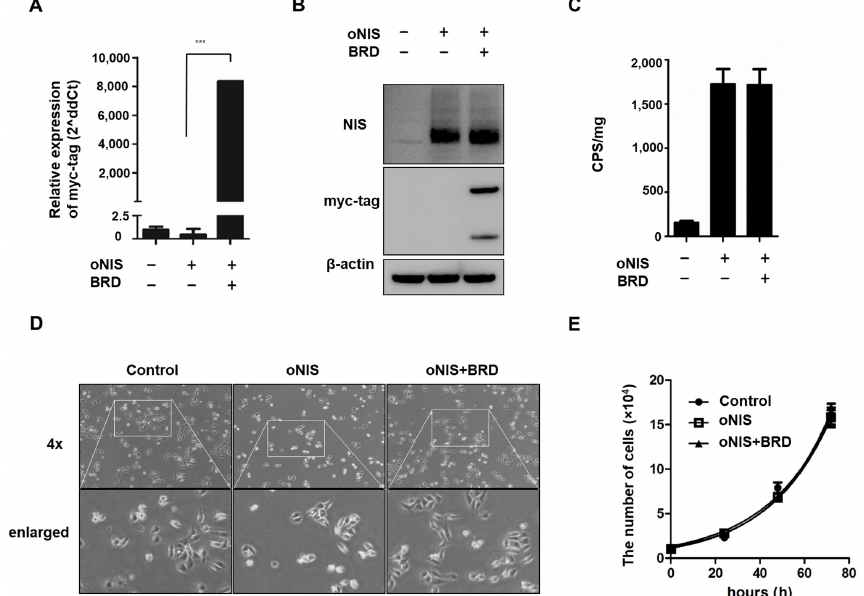
Figure 1. Establishment of oNIS and oNIS+BRD cells. ( A ) Transcriptional levels of BRG1-BRD were quantified by real-time RT–qPCR. The qPCR data were normalized by GAPDH. Data are presented as the means ± S.D (n = 4). ( B ) oNIS or oNIS+BRD overexpression was evaluated by Western blot. ( C ) Transfection efficiency was evaluated by an I-125 uptake assay. CPS is counts per second. ( D ) Microscopy images of nontransfected control, oNIS-, and oNIS+BRD-expressing cells. The morphology did not change after viral infection. A 4× scanning objective lens was used which gives a total 40× magnification. ( E ) Measurement of the cell proliferation rate among the control, oNIS-, and oNIS+BRD-expressing cells. Values are means ± S.E.M. p < 0.001 (***).